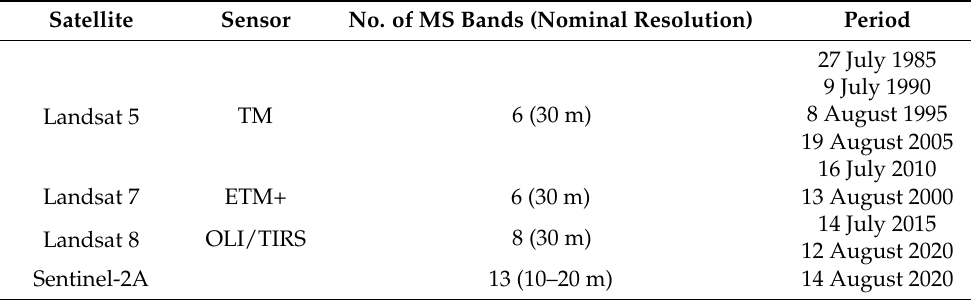
Table 2. Satellite products used for the study.